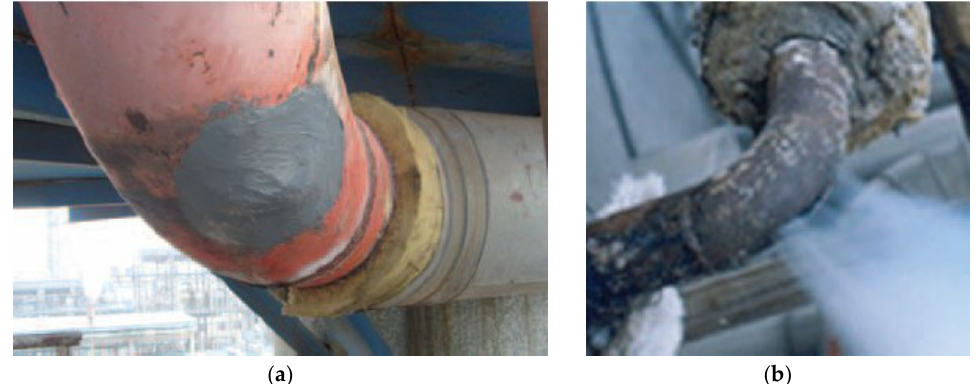
Figure 1. Actual damaged pipelines [4] ( a ) a failure of bend after repairing; ( b ) a failure of bend in a gas pipeline.